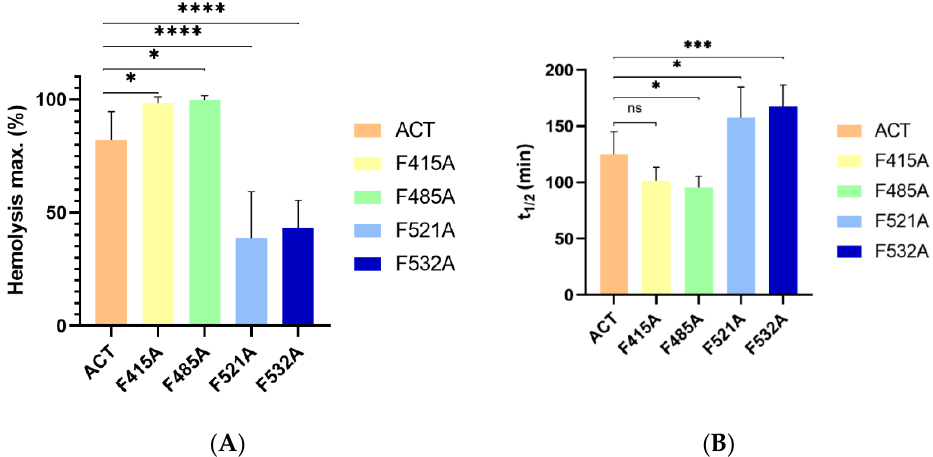
Figure 6. Effect of Ala substitutions in the central Phe residues of the potential cholesterol-binding sites CRAC 415 , CARC 485 , CRAC 521 and CARC 532 on the ( A ) maximum haemolytic percentage, and ( B ) t 1/2 of the ACT-induced haemolysis. Haemolysis induced by 50 nM of intact ACT or by each one of the four mutant toxins was assayed with a suspension of sheep erythrocytes (5 × 10 8 cells/mL) incubated with each protein for 180 min at 37 °C. Data represented in the figure correspond to the mean of three independent experiments ± SE. p -values for the plot in the left subpanel * p = 0.0444 (ACT/F415A); * p = 0.0262 (ACT/F485A); **** p < 0.0001; p -values for the plot in the right subpanel * p = 0.0202 (ACT/F485A); * p = 0.047 (ACT/F521A); *** p = 0.0008.